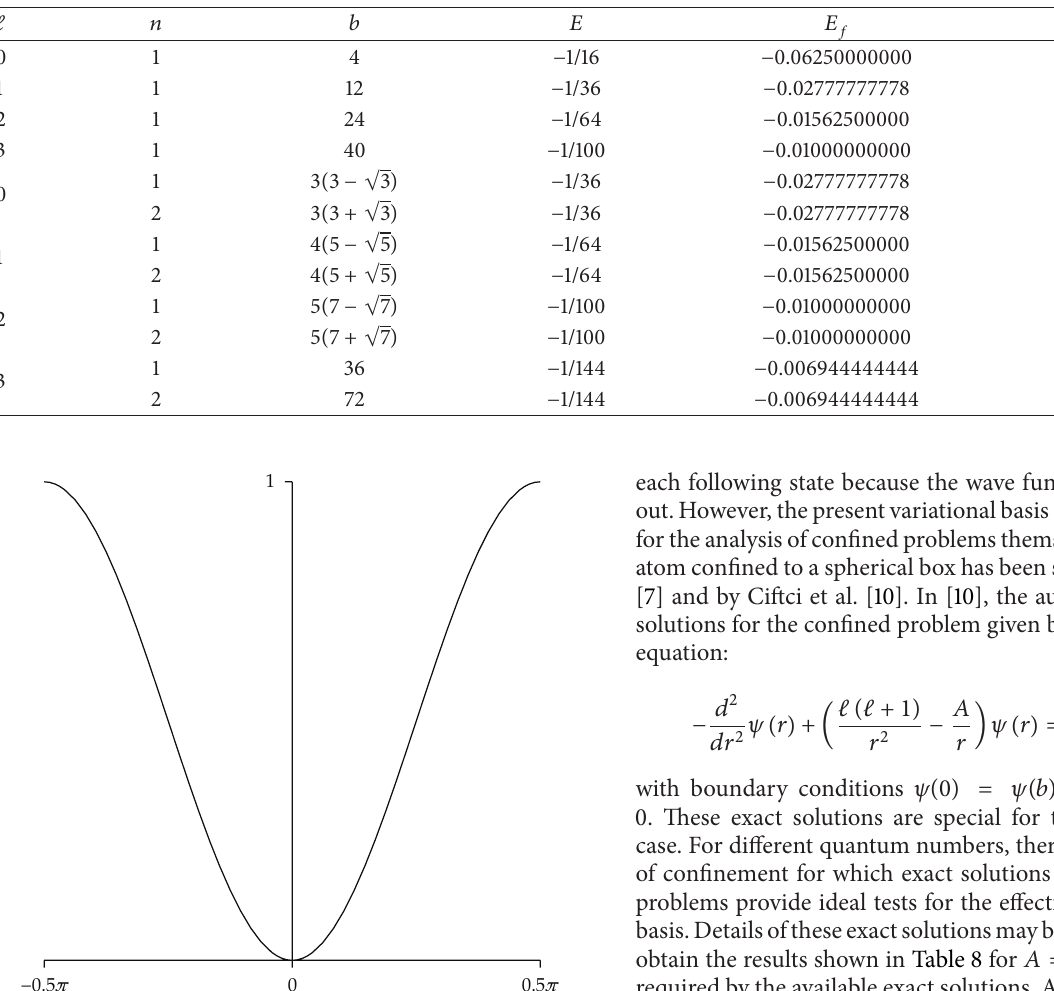
𝑓 is the expression